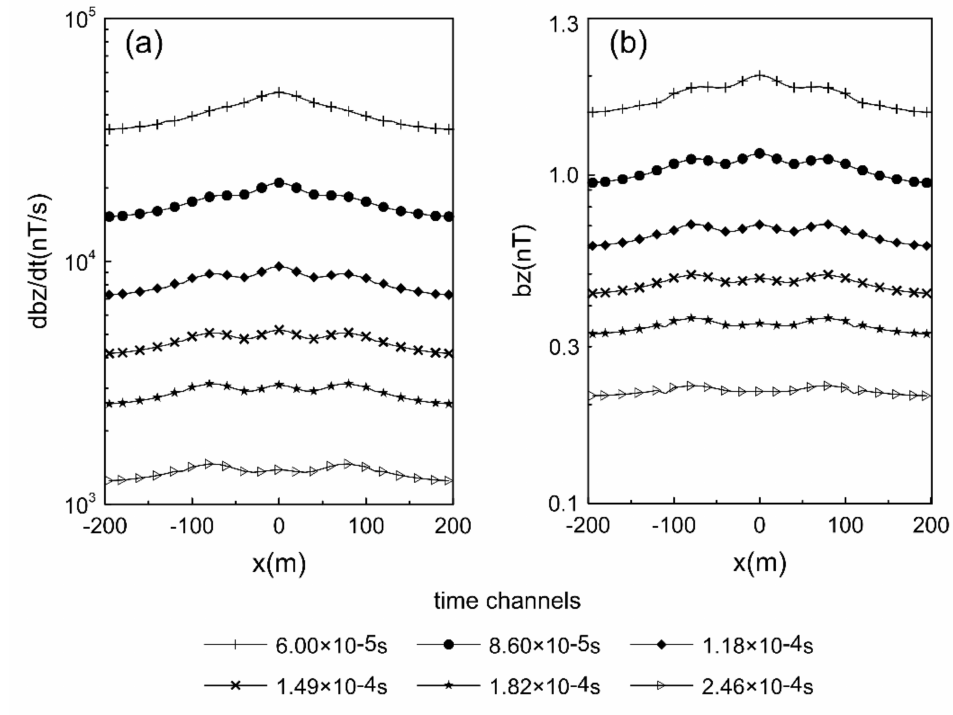
Figure 10. ( a ) dbz/dt and ( b ) bz responses for the vertical dyke model in Figure